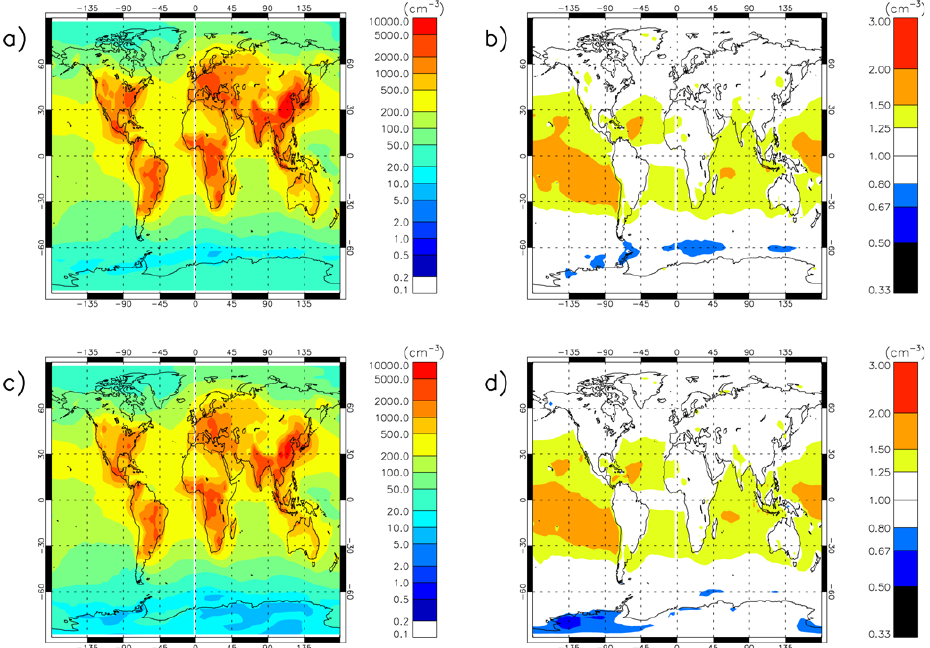
Fig. 9. Global surface maps showing CCN concentrations for (a) dry diameter > 50nm (CCN 50 ) and (c) dry diameter > 70nm (CCN 70 ), as simulated by GLOMAP-mode (v6R) on the annual-mean. The ratio of GLOMAP-mode (v6R) to GLOMAP-bin simulated CCN 50 and CCN 70 are shown in panels (b, d) , respectively. Regions coloured yellow, orange and red in the relative bias maps indicate where GLOMAP- mode is higher than bin by 25–50, 50–100 and 100–200%, respectively, whilst light-blue, dark-blue and black indicate where bin is higher by the same proportions. Regions where the two schemes are within 25% are colored white.